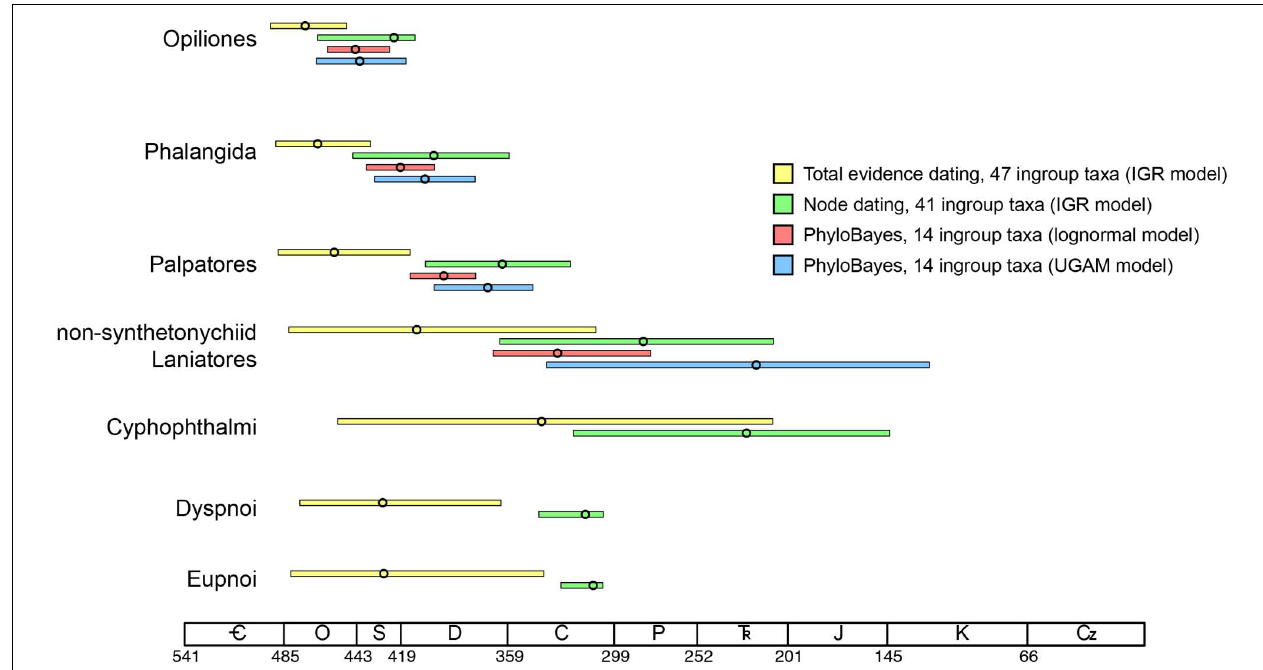
FIGURE 5 | Comparison of the four dating strategies adopted in this study, showing 95% highest posterior density intervals and median ages (circles) for nodes of interest. Results of phylogenomic data set are